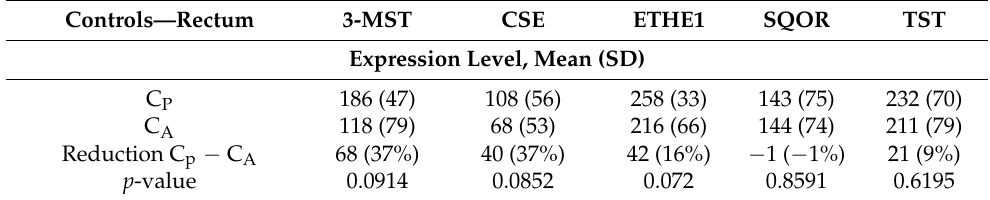
Table 3. Expression as mean with standard deviation (SD), absolute reduction and percentage as well as p -value of the rectum of the healthy control group (C) separated by age group. Pediatric (P); adult (A). cystathionine- γ -lyase (CSE), 3-mercapto-sulfurtransferase (3-MST), ethylmalonic encephalopathy 1 protein (ETHE1), sulfide:quinone oxidoreductase (SQOR) and thiosulfate sulfurtransferase (TST).